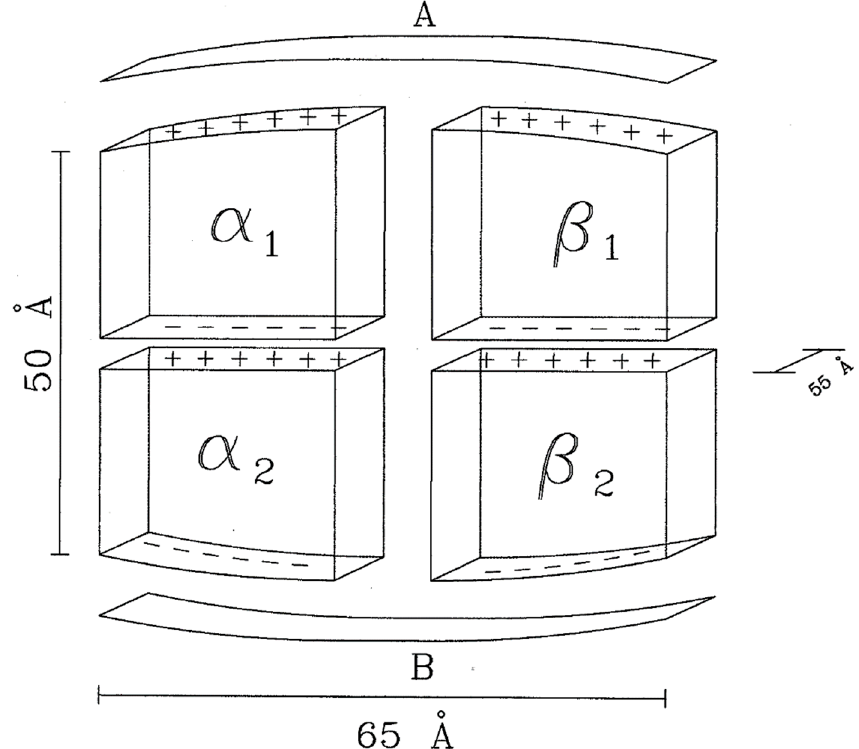
Figure 1. Hemoglobe: schematic model of the four subunits of the Hb assembled to form a capacitor with two faces A and B and surface S (armatures) with relative charges and characteristic dielectric (great part of the internal mass is the quaternary structure).